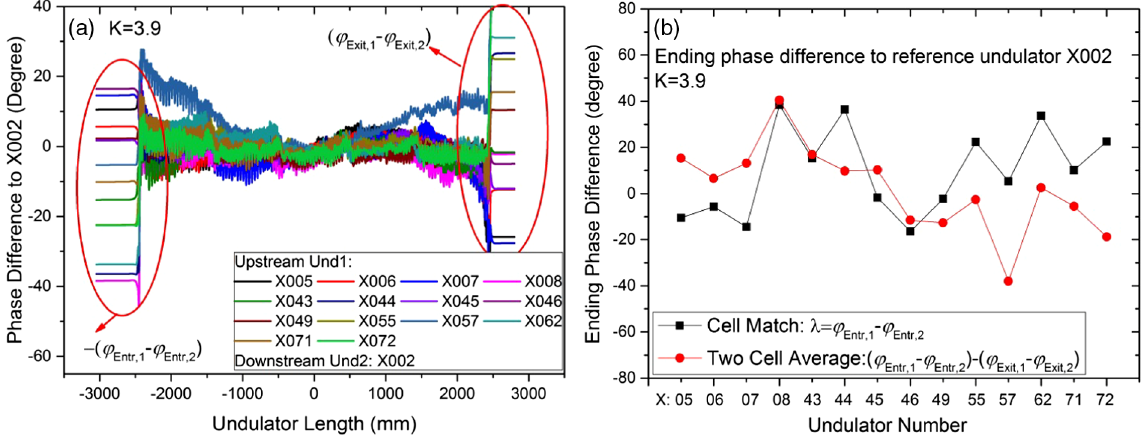
FIG. 3. The phase difference between the 14 undulators to a reference undulator. (a) The phase difference over the full length of the undulator. (b) Test of the valid conditions for the simplified matching